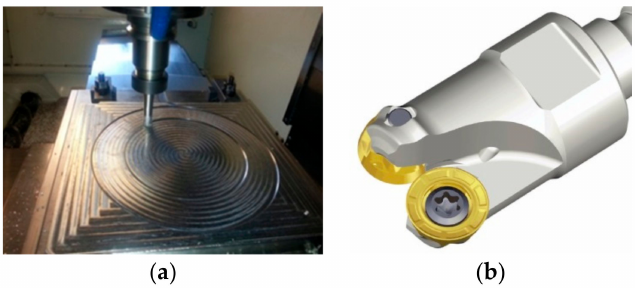
Figure 3. ( a ) Machining strategy used in all tests; ( b ) tool holder (www.taegutec.com).